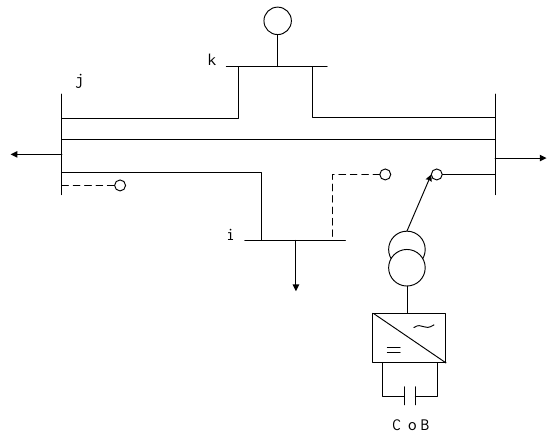
Figure 2. Multiple compensations in an